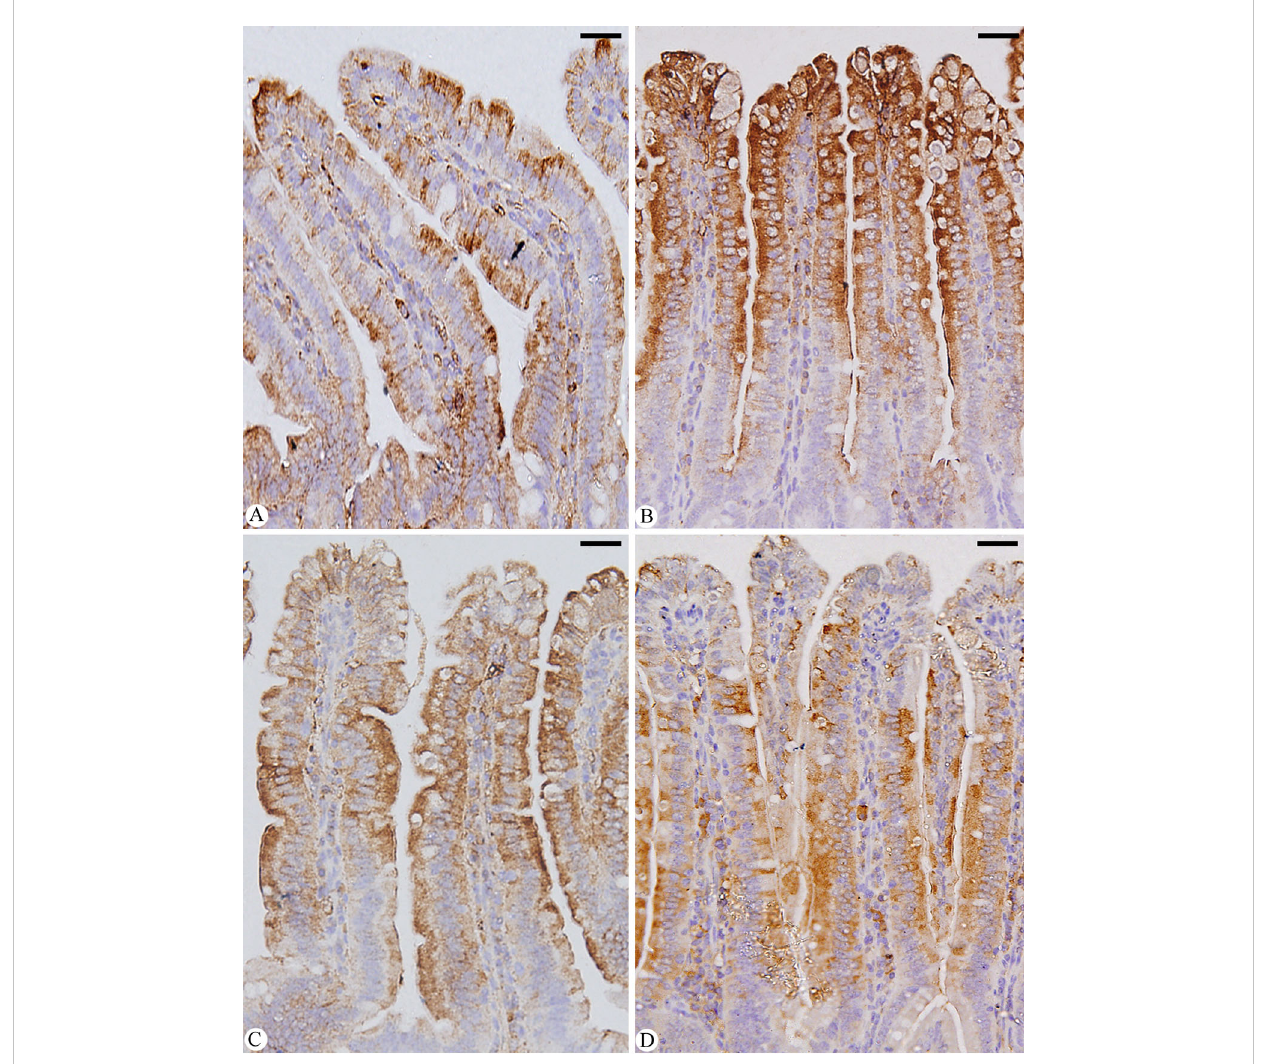
FIGURE 8 Immunohistochemical localization of CASP-3 in the jejuna of mice. (A) control non-infected jejunum. (B) E. papillata infected jejunum with an increased number of CASP-3 positive cells. (C, D) infected treated mouse (Bio-SeNPs and AMP, respectively) with decreased number of CASP-3 positive cells. Scale bar = 100µm.